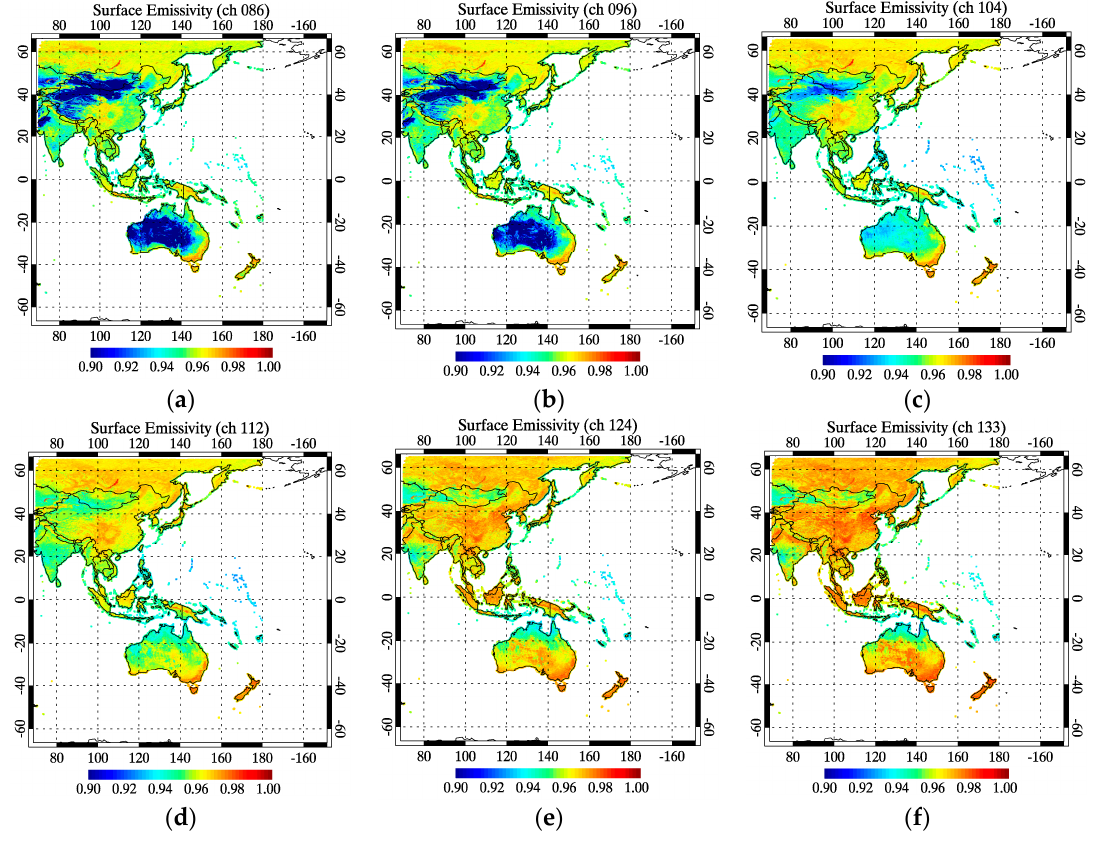
Figure 5. Monthly climatological land surface emissivity data for AHI channels ( a ) 8.6, ( b ) 9.6, ( c ) 10.4, ( d ) 11.2, ( e ) 12.4 and ( f ) 13.3 μ m.